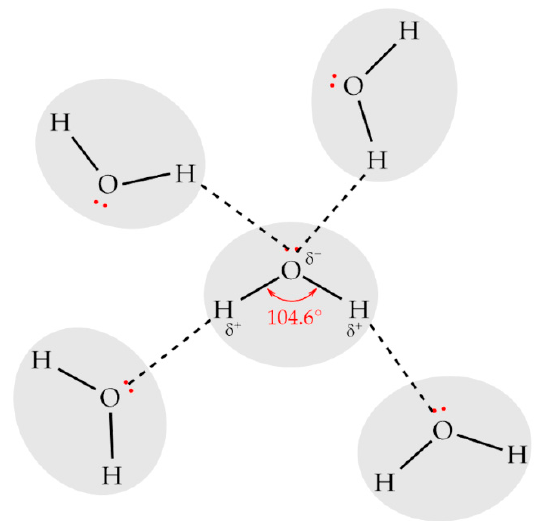
Figure 1. Structure of a 4-coordinated water molecule. Hydrogen atoms are positively charged ( δ +) and oxygen atoms are negatively charged ( δ− ), which also present a lone pair of electrons. Solid lines indicate covalent bonds and dashed lines, hydrogen bonds.